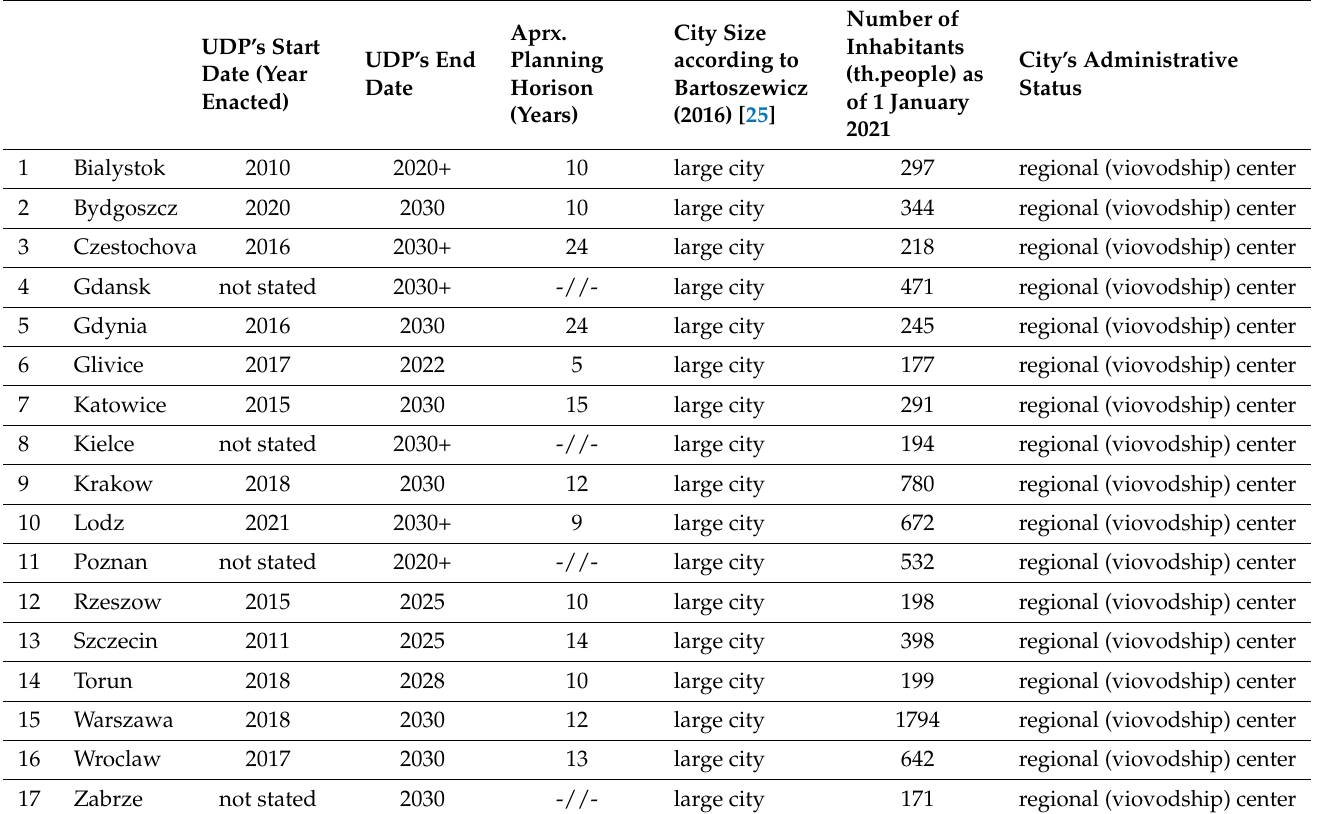
Table 1. Overview of UDPs selected for the